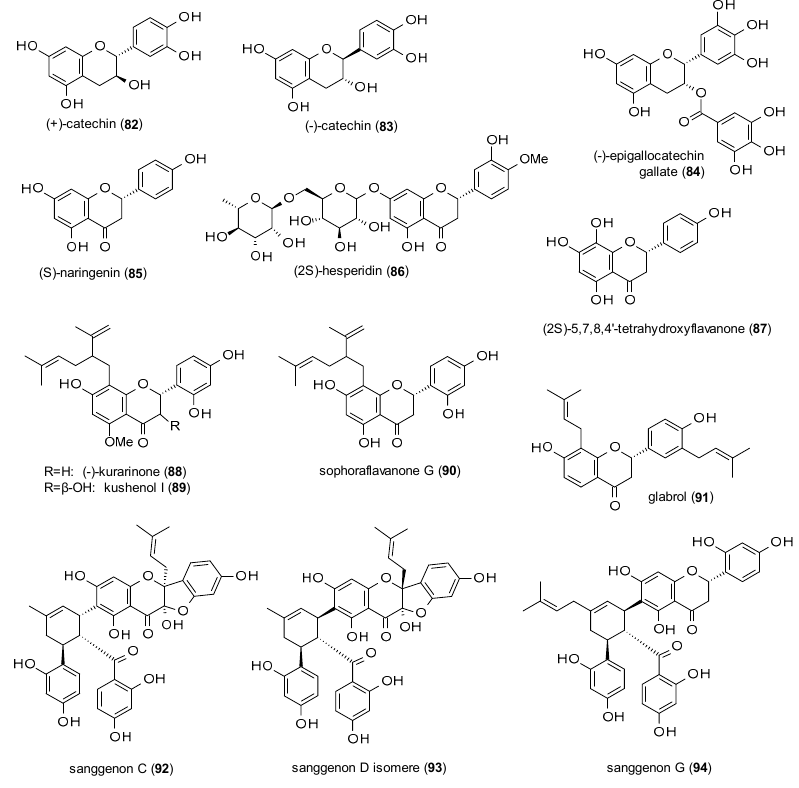
Figure 5. Chemical structures of flavanes with reported GABA(A)-receptor modulating activity. (+)- and ( − )-catechin ( 82 and 83 ) have been tested for their effect on [³H] γ -hydroxybutyric acid (GHB) binding and on the binding of [³H]NCS-382, a GHB antagonist in order to find new lead compounds for the GHB high-affinity site of the GABA(A) receptor [76]. (+)-catechin enhanced [³H]NCS-382 binding to 163% and decreased [3H]GHB-binding to 54%, whereas ( − )-catechin was less